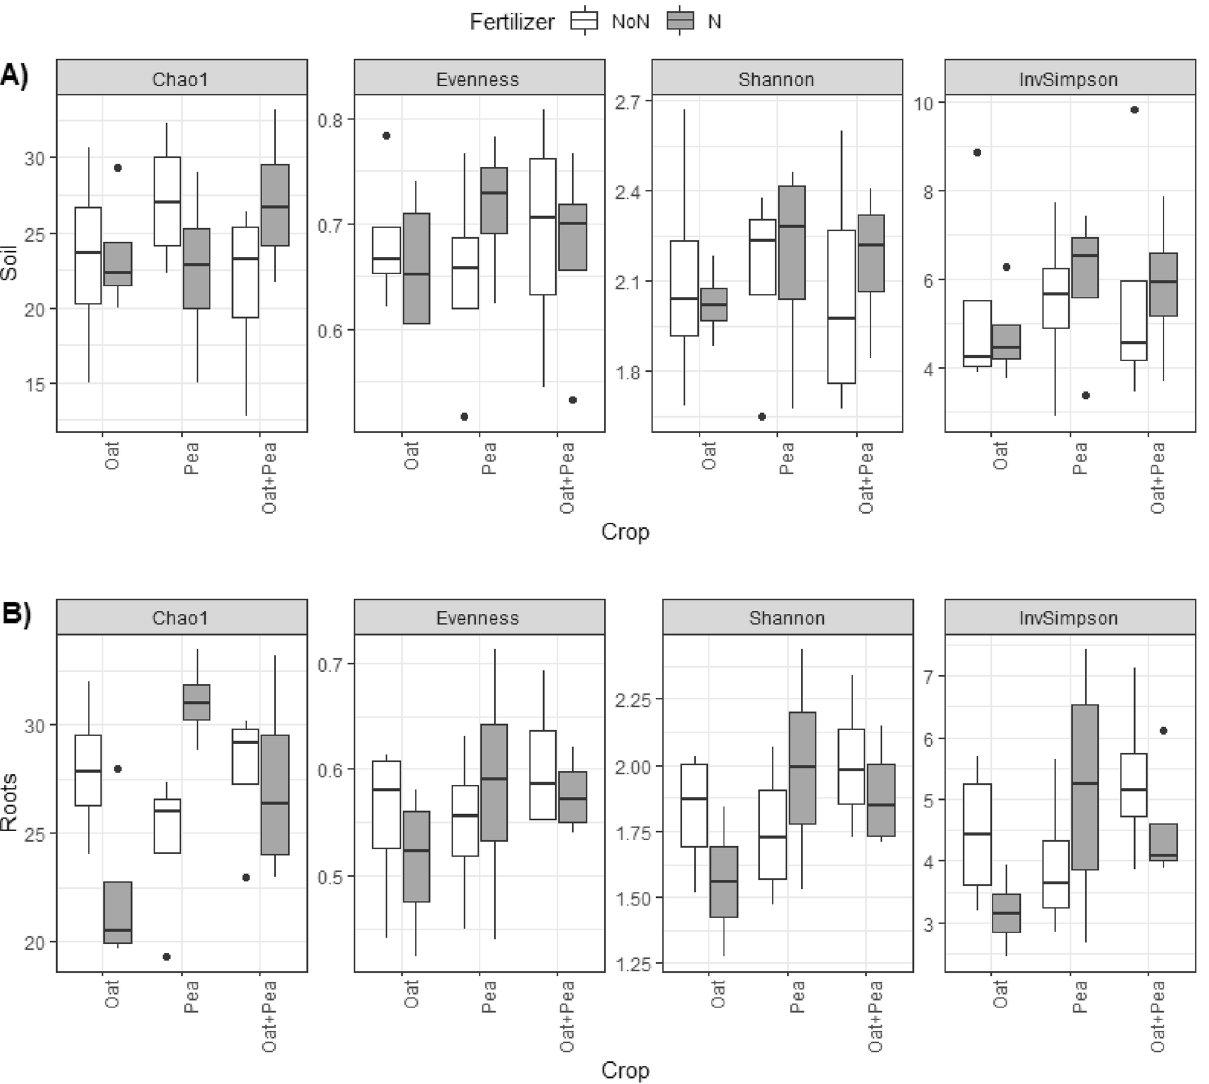
Figure 1. Arbuscular mycorrhizal fungi (AMF) alpha diversity including Chao1 richness, Peilou’s Evenness, Shannon diversity and inverse Simpson diversity across cropping systems at ( A ) bulk soil and ( B ) roots in